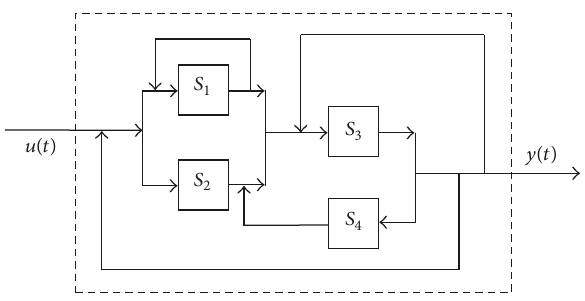
Figure 1: A diagram of a system coupled through